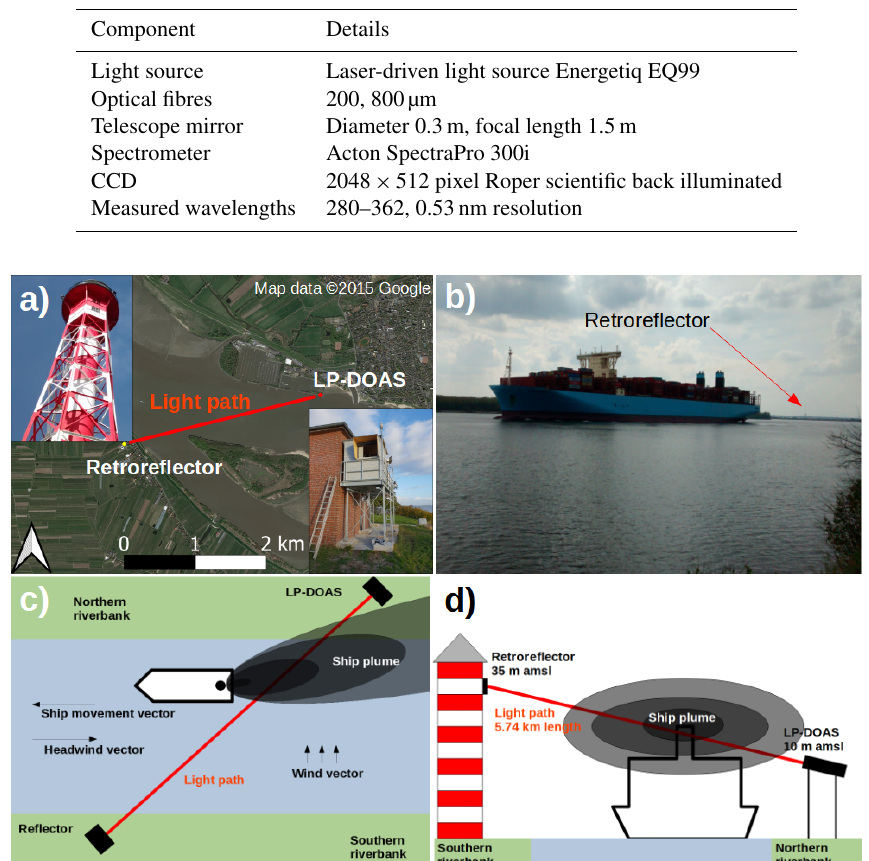
Figure 1. (a) Satellite image of instrument location, with the LP-DOAS marked as a red dot on the northern river bank and the retroreflector position marked as a yellow dot on the southern river bank. (b) Image of a passing container ship next to the measurement site. (c) Schematic overview of the measurement geometry of the LP-DOAS for a passing ship leaving Hamburg towards the North Sea, seen from above. (d) Same as panel (c) but seen from the port of Hamburg. Note that panels (c) and (d) are not to